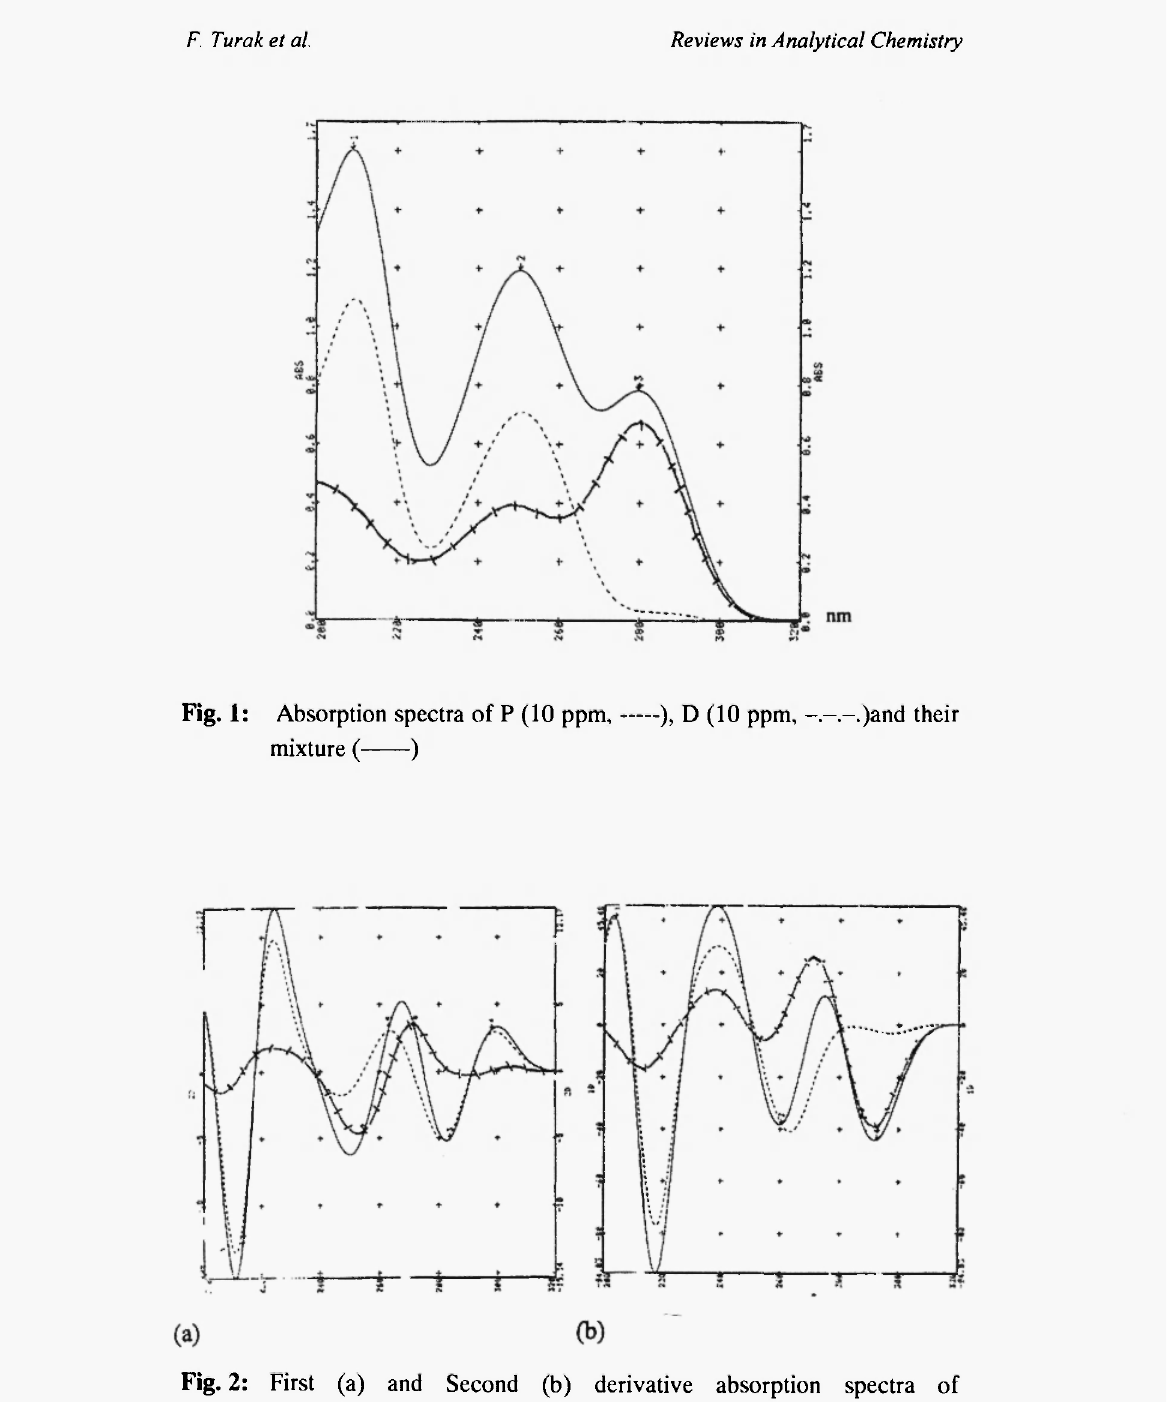
Fig. 2: First (a) and Second (b) derivative absorption spectra of Ρ (10 ppm, ), D (10 ppm, -.-.-.) and their mixture ( )